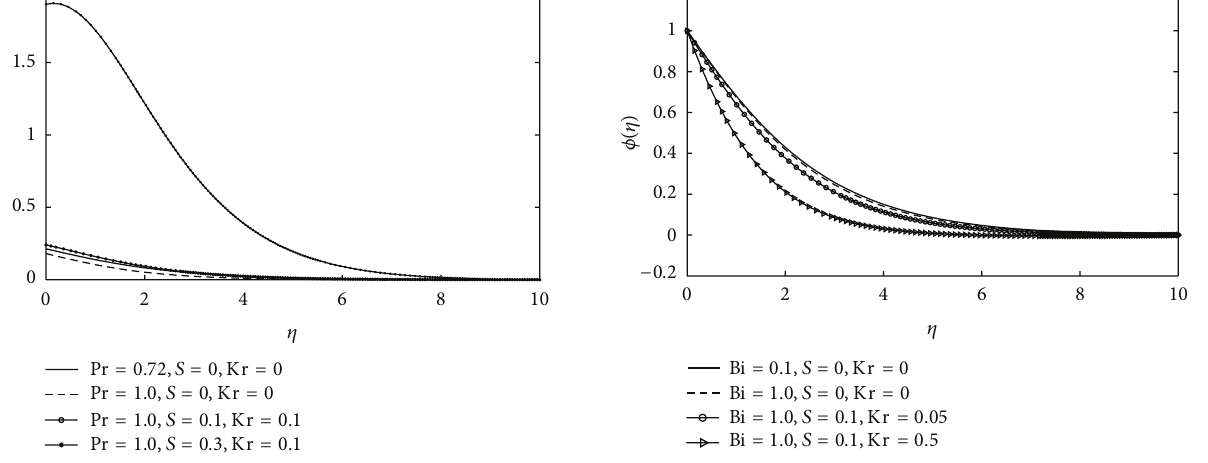
Figure 15: Concentration profiles for different values of Bi, 𝑆 , and Kr for Ha = 0.1 , Gr = 0.1 , Gc = 0.1 , Sc = 0.62 , Nc = 0.01 , and Pr = 0.72 .